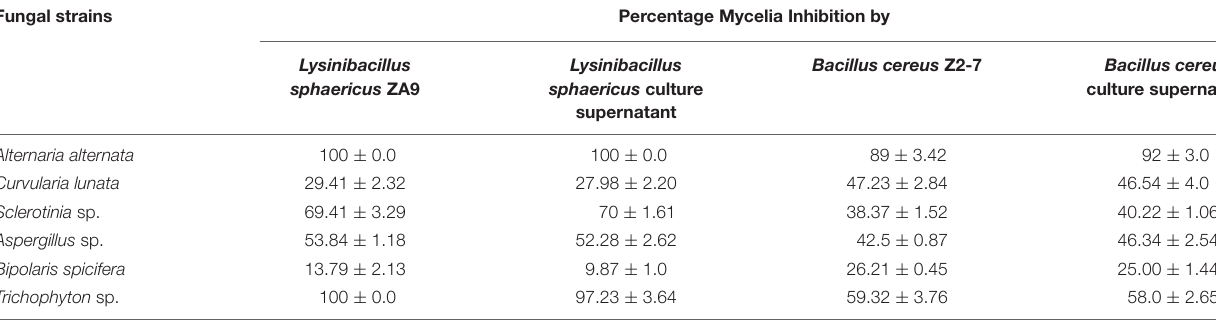
TABLE 2 | Antagonistic activity of L. sphaericus ZA9 and Bacillus cereus Z2-7 against different fungi as detected by dual culture assays. Fungal strains